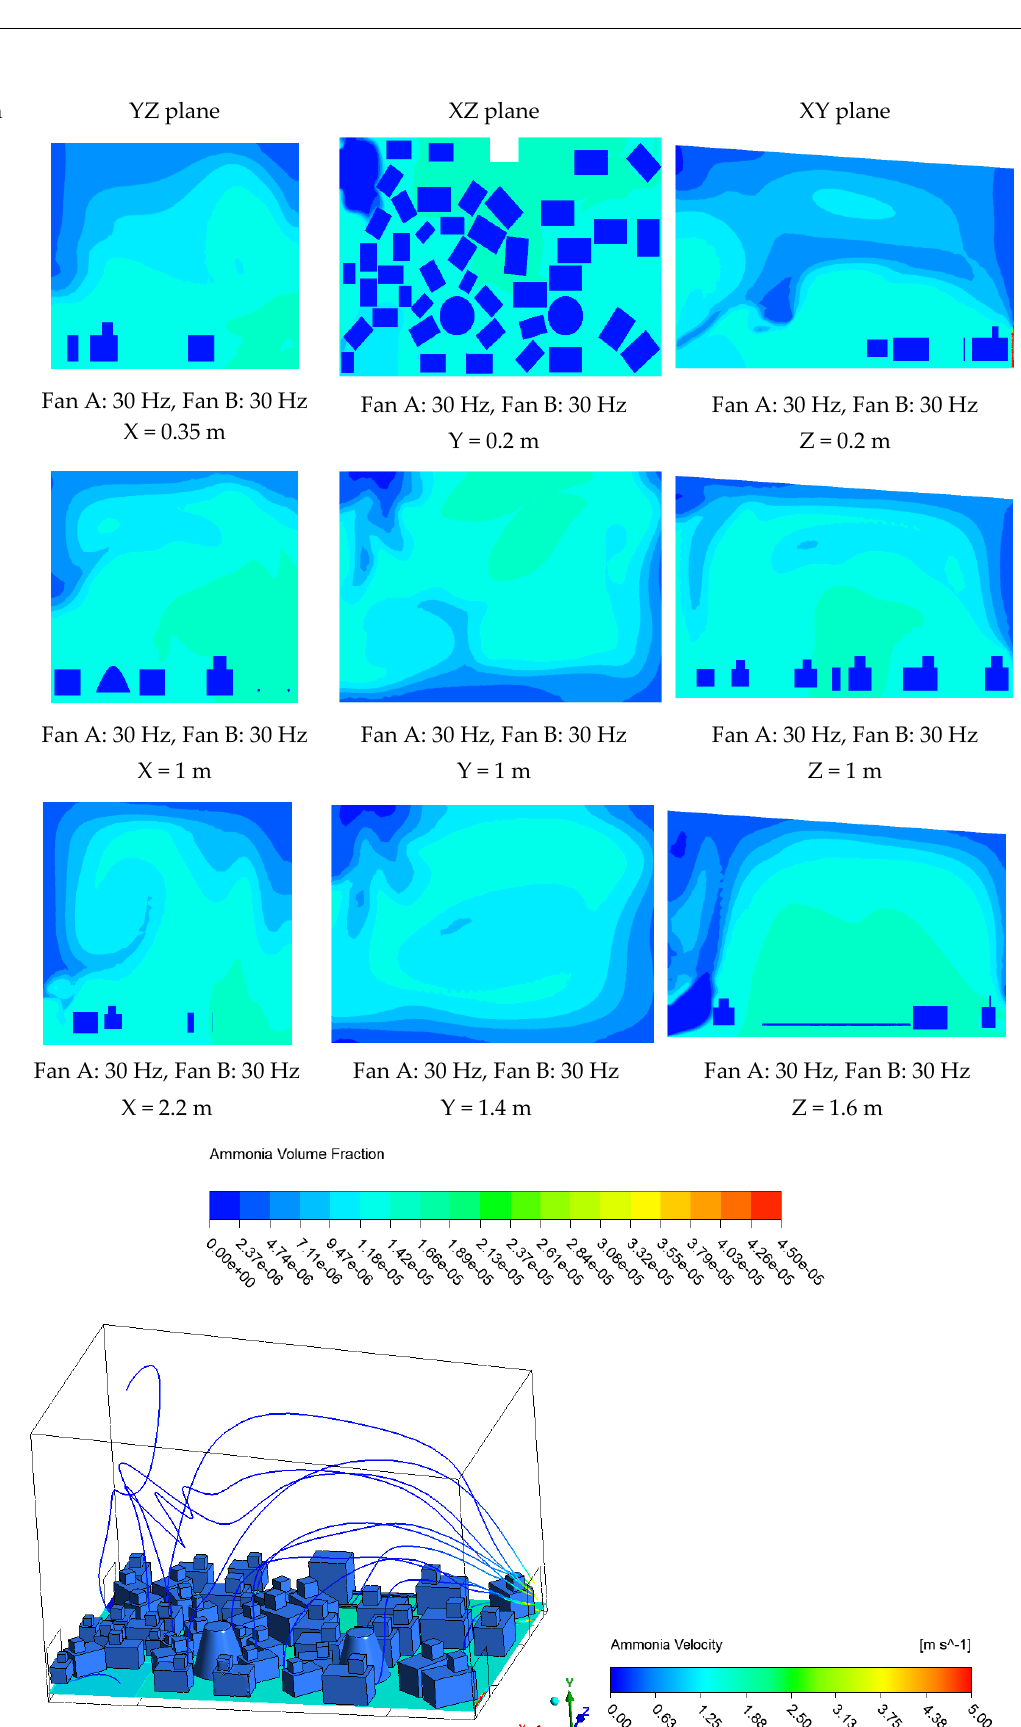
Figure 11. Simulation results of ammonia concentration distribution under working condition 3. If the ventilation system works in working condition 3, the concentration of ammonia in the whole broiler chamber is lower than 10 ppm, which meets the requirements of breeding. The suitable growth temperature for broilers is about 20 degrees Celsius. How- ever, the temperature in Nanjing, Jiangsu Province of China, is rarely higher than 20 de- grees Celsius during winter, so it works in working condition 1. The ammonia concentra- tion of the broiler chamber was higher, and the whole broiler chamber was more than 30 ppm without the ventilation of the negative pressure fan. Furthermore, the ammonia con- centration in the middle part of the broiler chamber was even more than 40 ppm, which is more than twice the requirement of the high concentration standard of ammonia. If the ventilation system works in working condition 2, the concentration of ammonia in the broiler chamber is in a small area of the air inlet of the external circulation, and the rest of the area is more than 20 ppm. As a result, the broiler chamber has improved ventilation requirements in the winter. Through the three-dimensional model of the broiler chamber, it can be observed that the two air inlets lift significantly after contact with the ground air. This will suppress the ammonia diffusion in the living layer of the broiler, resulting in the ammonia concentration in the living layer of the broiler being significantly higher than in the upper space of the broiler chamber. Therefore, it is still suggested that an outlet on the